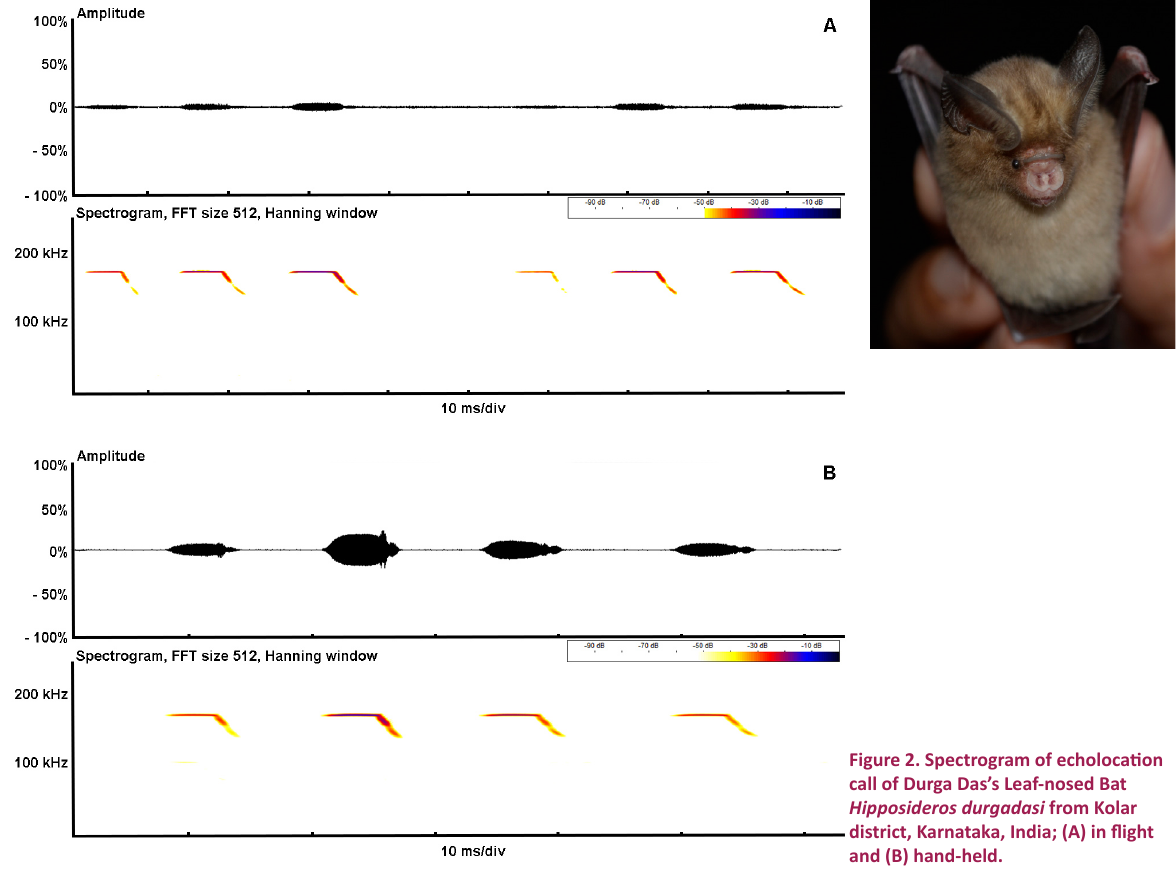
Figure 2. Spectrogram of echolocation call of Durga Das’s Leaf-nosed Bat Hipposideros durgadasi from Kolar district, Karnataka, India; (A) in flight and (B)